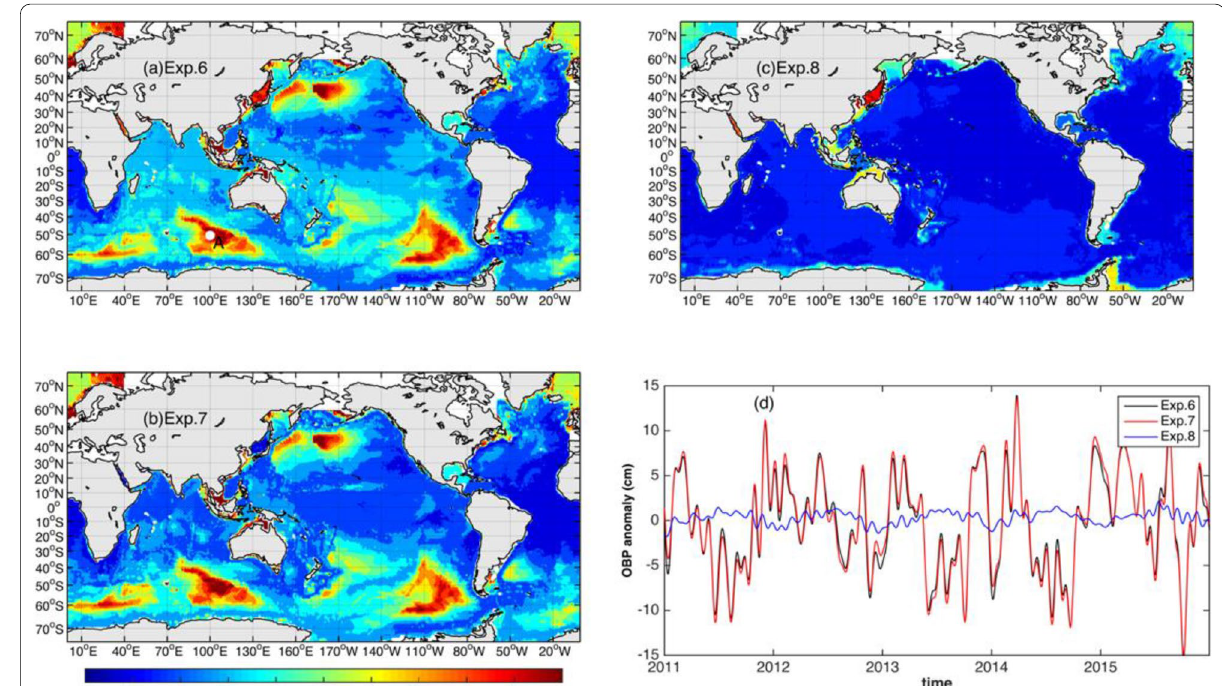
Fig. 7 a Standard deviation (STD, cm) of low-pass-filtered ocean bottom pressure anomalies with period longer than 30 days during 2003–2018 for Exp. 6, b same as a but for Exp. 7, c same as a but for Exp. 8, d ocean bottom pressure time series at point A during 2011–2015 for Exp. 6 (black curve), Exp. 7 (red curve) and Exp.8 (blue curve). Station A in Fig. 7a is located at (100 °E, 50